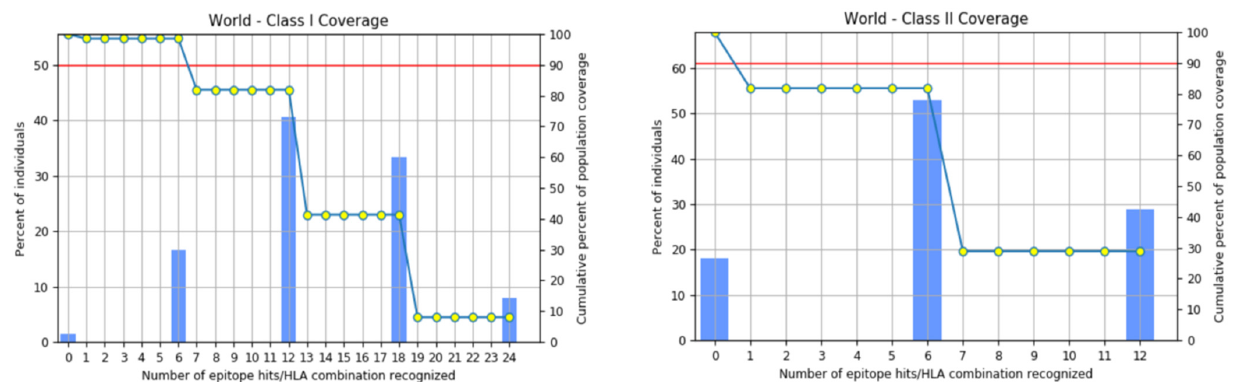
Figure 5. Worldwide coverage of MHC classes I and II allele HLA perceived as a set of predicted epitopes of T cells. Graphs for the worldwide class I and II populations coverage represent the relationship between the number of individuals and the number of epitope–allele combinations. The cumulative percentage for the MHC I coverage is observed as 98.98%, while for MHC II it is 94.71%.